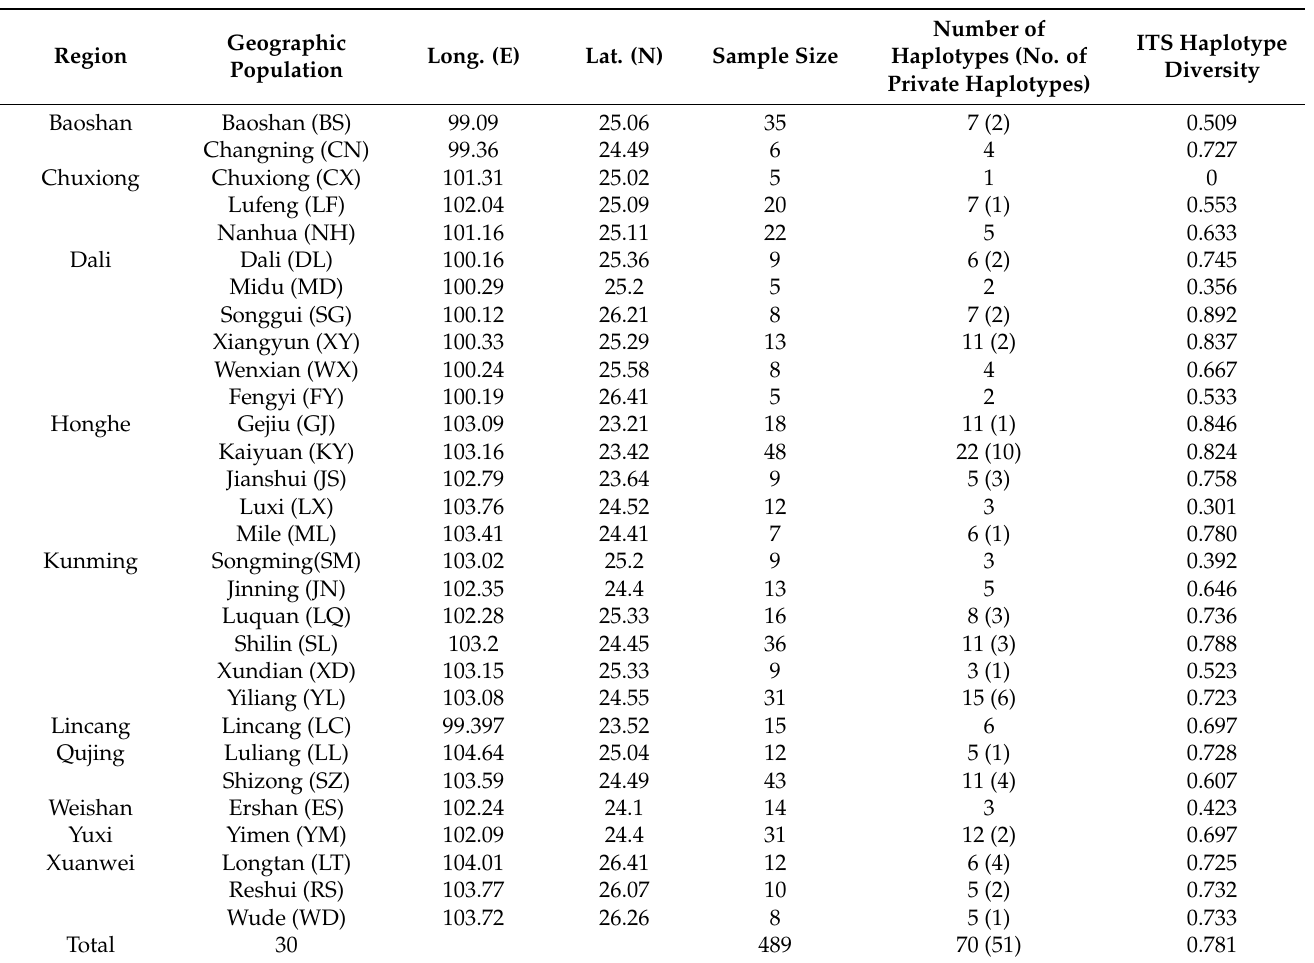
Table 1. Distribution and diversity of ITS sequence types for Thelephora ganbajun from Yunnan province, southwestern